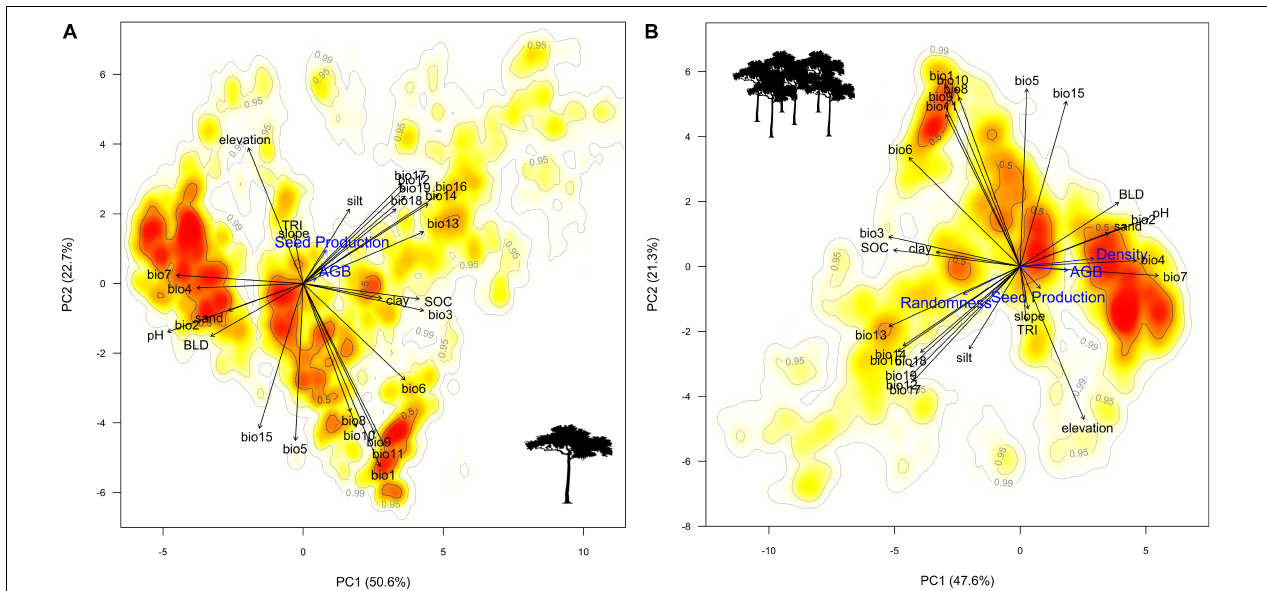
FIGURE 5 | Ordination plots showing the first two axes of principal component analyses of tree-centric Brazil nut variables (A) and area-based Brazil nut variables (B) . The color gradient indicates regions of the highest (red) to lowest (white) densities of data points, i.e., individual Brazil nut trees in (A) and 7.5-arc-second grid cells in (B) , through use of Kernell density estimations. Please note that randomness is inversely related with spatial aggregation. Arrows of the response variables were doubled (B) to tripled (A) in length to improve interpretation. Bio1, annual mean temperature; Bio2, mean diurnal range; Bio3, isothermality (Bio2/Bio7) (100 × ); Bio4, temperature seasonality; Bio5, max temperature of the warmest month; Bio6, min temperature of the coldest month; Bio7, temperature annual range (Bio5–Bio6); Bio8, mean temperature of the wettest quarter; Bio9, mean temperature of the driest quarter; Bio10, mean temperature of the warmest quarter; Bio11, mean temperature of the coldest quarter; Bio12, annual precipitation; Bio13, precipitation of the wettest month; Bio14, precipitation of the driest month; Bio15, precipitation seasonality; Bio16, precipitation of the wettest quarter; Bio17, precipitation of the driest quarter; Bio18, precipitation of the warmest quarter; Bio19, precipitation of the coldest